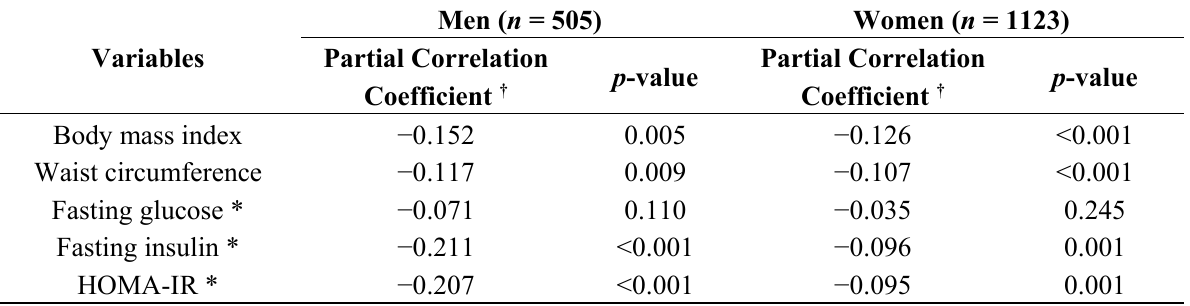
Table 3. Pearson’s correlation coefficients between serum 25(OH)D * and other variables. Men ( n = 505) Variables Partial Correlation Body mass index Waist circumference − 0.117 <0.001 Fasting glucose * − 0.071 0.110 Fasting insulin * − 0.211 − 0.207 <0.001 0.001